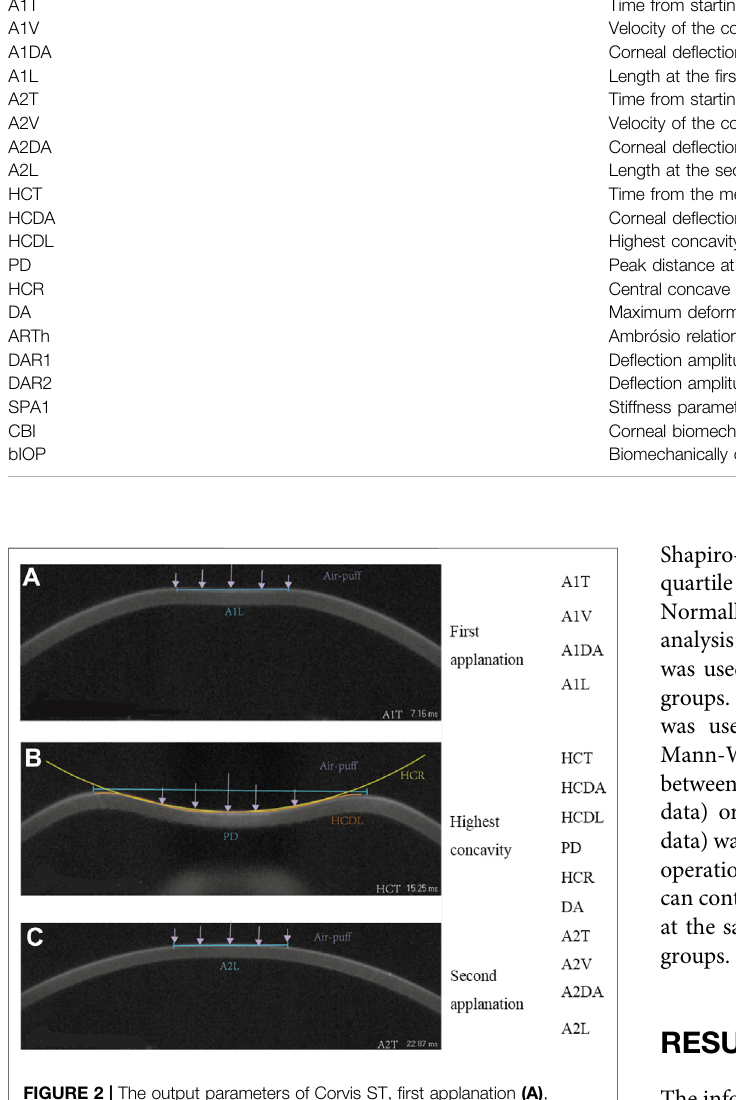
Frontiers in Bioengineering and Biotechnology |